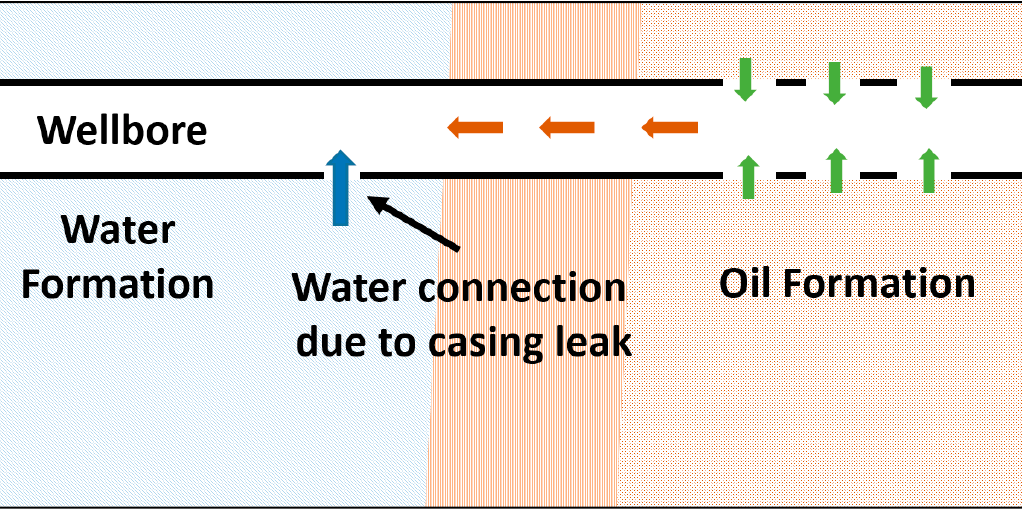
Figure 5. Casing leak connecting the wellbore with water formation.